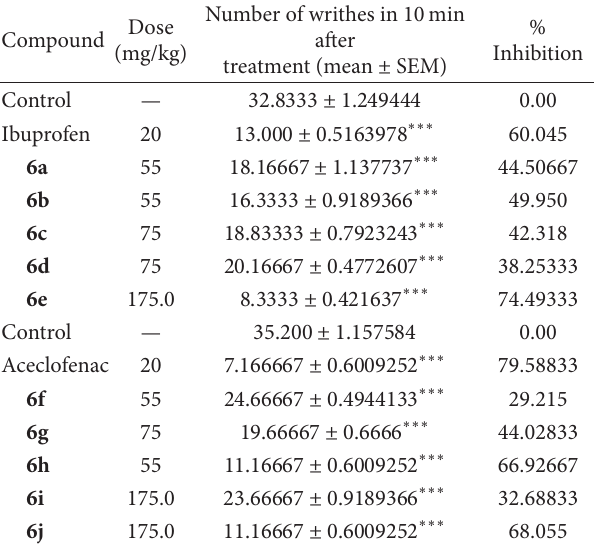
T 6: Analgesic activity of compounds 6a–6j